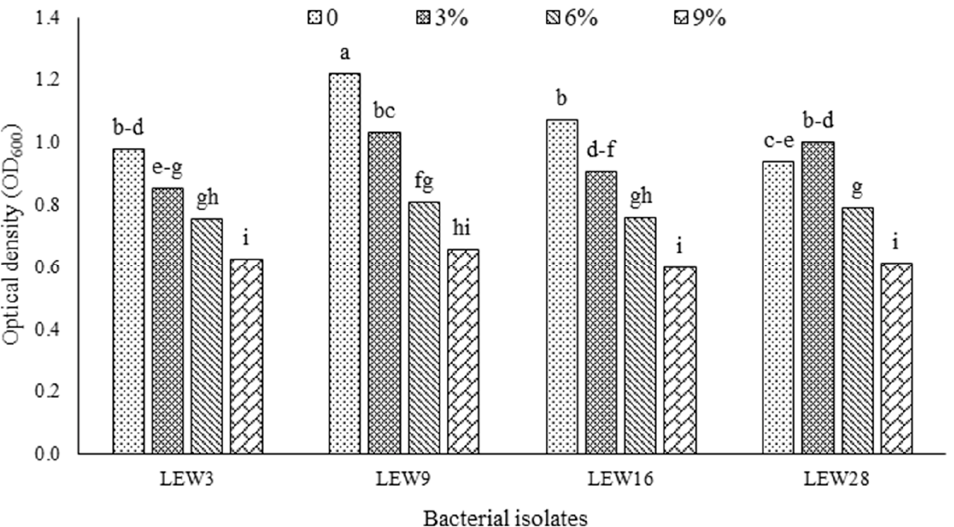
Figure 1. Effect of different levels of PEG-6000 on growth of EPS- and IAA-producing drought- tolerant rhizobacterial isolates in liquid culture after 72 h of incubation. Bars sharing same letter(s) do not differ from one another ( p ≤ 0.05).